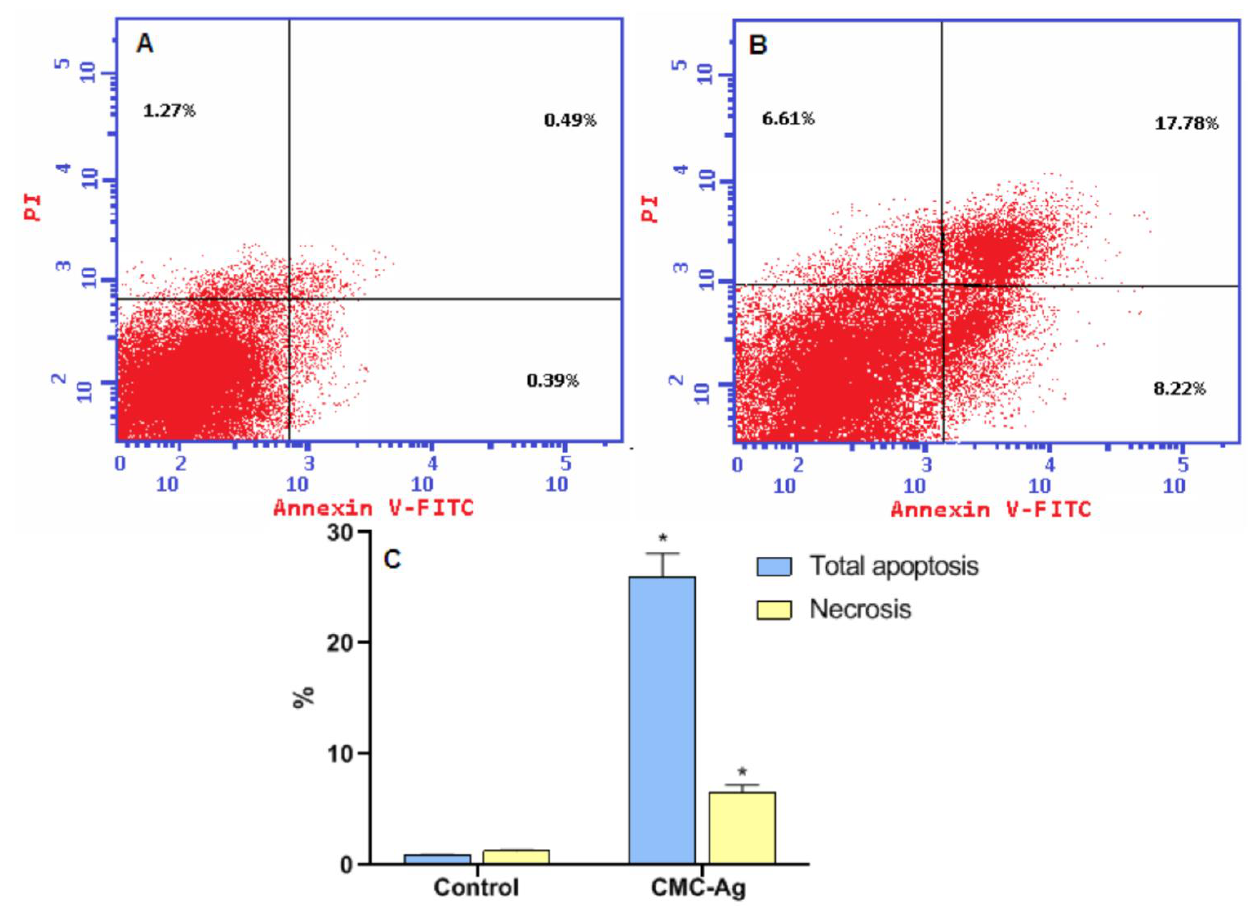
Figure 6. CMC-AgNPs induce apoptosis in the HepG2. ( A ) Control, ( B ) CMC-AgNPs, and ( C ) a graphical representation for % of apoptotic and necrotic cells. * Significantly different from the control group at p < 0.0001.